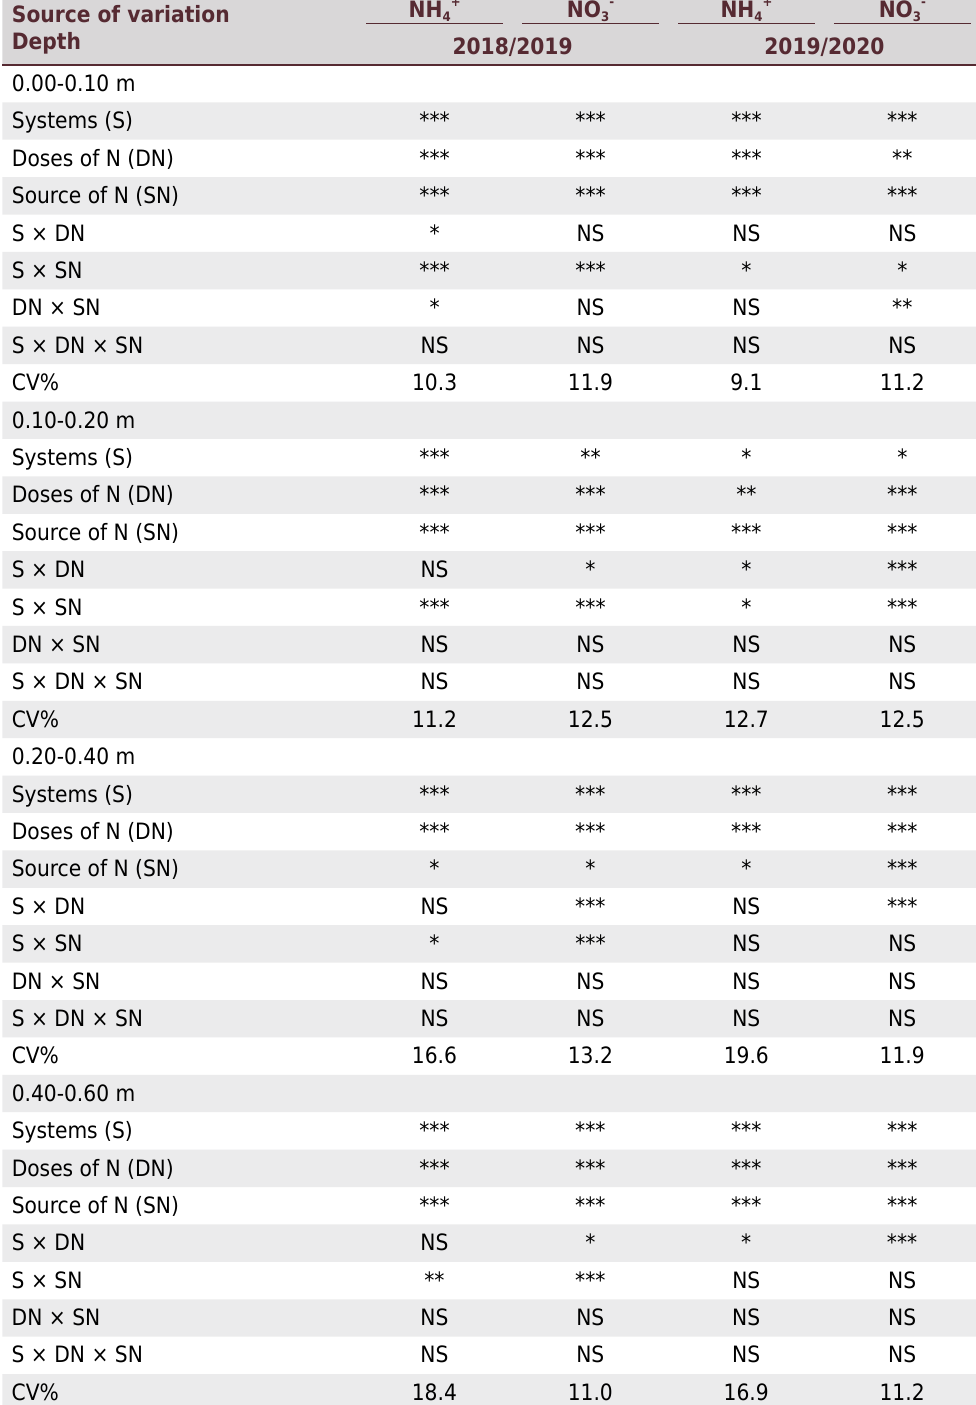
Table 4. Variance analysis summary of the ammonium and nitrate content in the soil at the layers of 0.00-0.10, 0.10-0.20, 0.20-0.40, and 0.40-0.60 m with different crop rotation systems, nitrogen sources, nitrogen doses, and